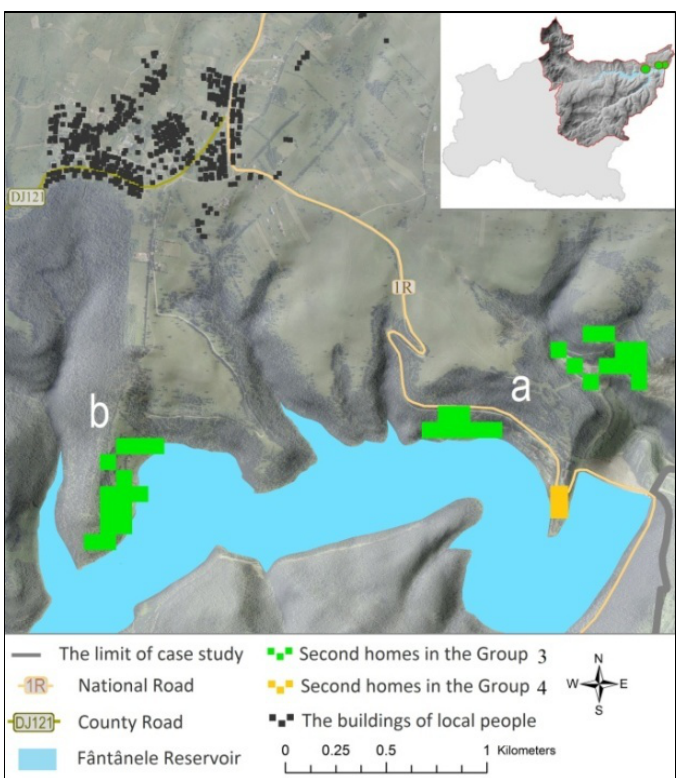
Figure 5: The spatial distribution of the groups 3 and 4 in the case of Fântânele Reservoir and other shoreline settlements with vacation homes (Beliș and Râșca Communes, Cluj